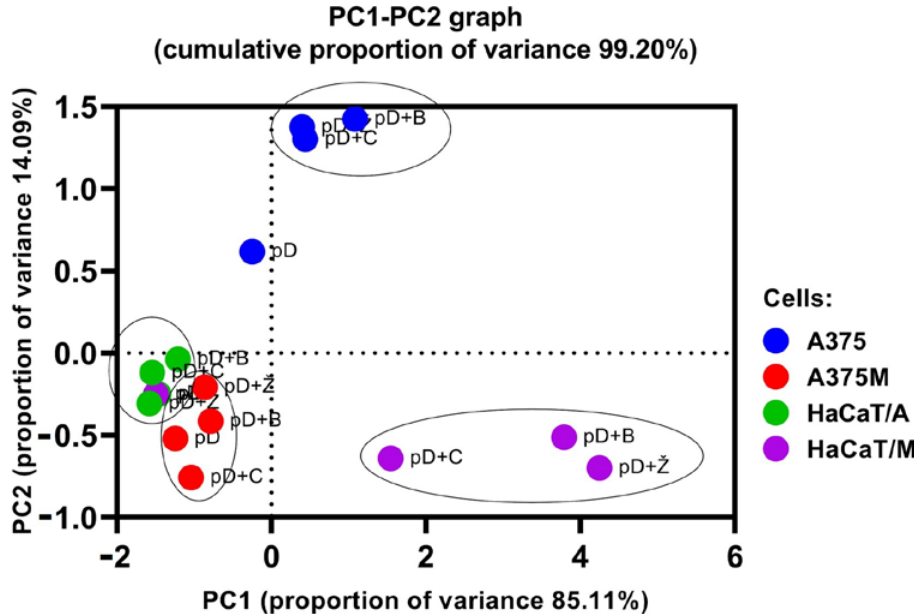
Figure 5. Principal component analysis (PCA) score plot. Principal component analysis (PCA) was performed on the data obtained from the measurement of cellular metabolic activity after 6 h pre-treatment with DTIC followed by the 24 h treatment of A375 and A375M cells with IC 60 concentrations of EVOO-PEs derived from three different cultivars (Žižolera, Bjelica, and Crnica). Comparative non-cancerous HaCaT cells were exposed to the same concentrations of EVOO-PEs as applied to A375 and A375M cells. Legends: pD—pre-treatment with DTIC; pD + Ž, pD + B, pD + C—pre-treatment with DTIC followed by exposure to EVOO-PEs derived from three different cultivars, Žižolera, Bjelica, Crnica, respectively; HaCaT/A and HaCaT/M—HaCaT cells exposed after DTIC pre-treatment to the same concentrations of EVOO-PEs as applied to A375 and A375M cells, respectively.